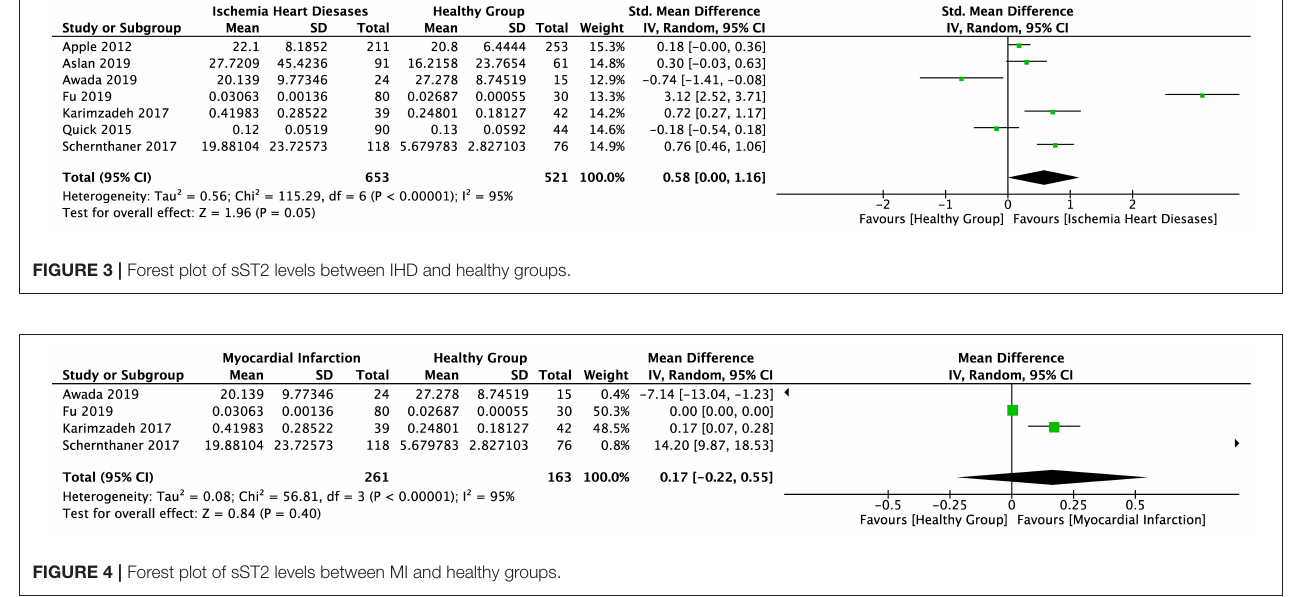
Molecular Biological Characteristic of ST2 ST2 is a member of the Toll-like/IL-1 receptor (TIR) superfamily, the members of which are defined by a common intracellular domain, the TIR domain (32). The functional ligand of ST2 is IL-33. sST2 can also directly bind to IL-33 and act as a decoy receptor, inhibiting